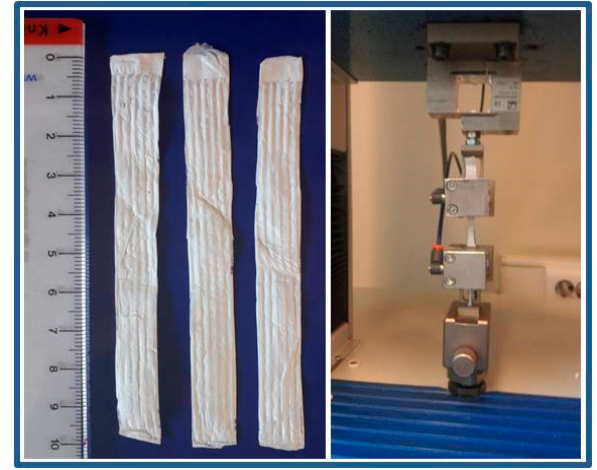
Figure 2. Tensile testing of the electrospun scaffolds.